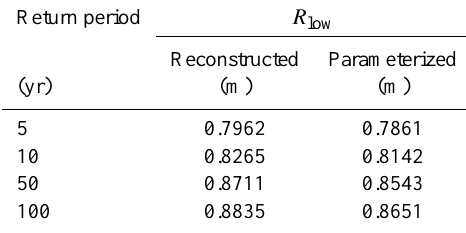
Table 4. Return values for R high corresponding to 5-, 10-, 50-, and 100-year return periods with the 95% confidence bounds values.